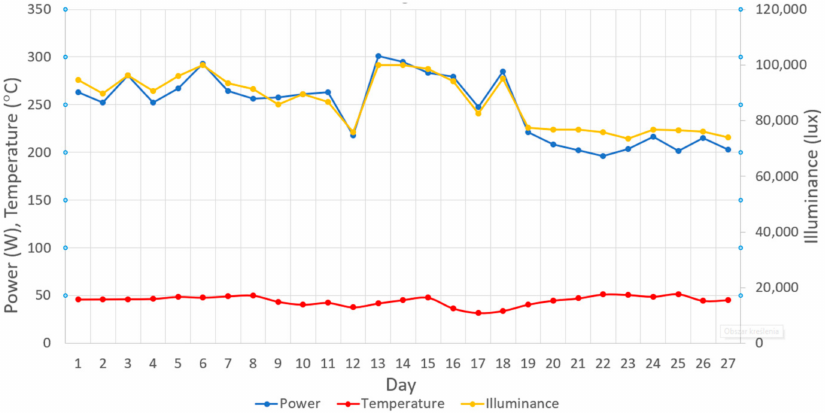
Figure 8. Power graph and illuminance in August